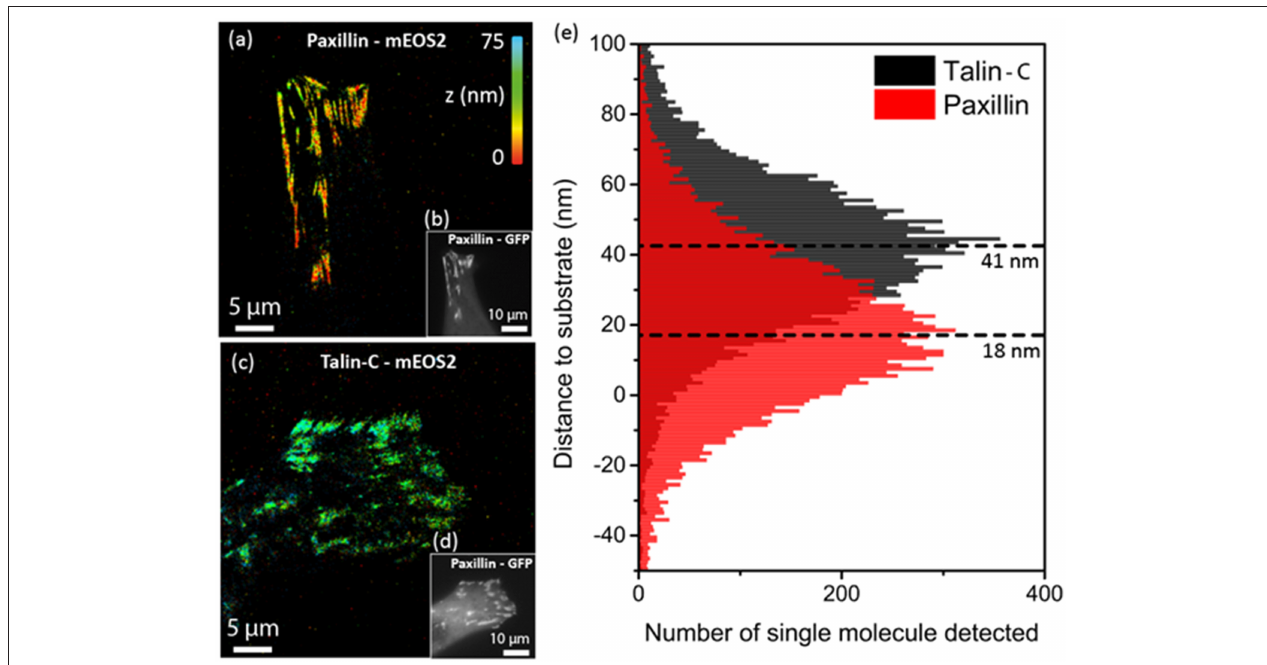
FIGURE 3 | PALM-based super-resolution imaging of Paxillin and Talin-C in live mouse embryonic fibroblasts. (a) Super-resolved image of Paxillin fused to mEOS2. (b) Epi-fluorescence image of GFP-Paxillin showing the adhesion focal points. (c) Same as (a) for Talin-C fused to mEOS2 on C-terminal part of the protein. (d) Same as (b) . (e) Histograms of the axial localizations of Talin-C and Paxillin within the adhesion focal points showing an axial separation of ∼